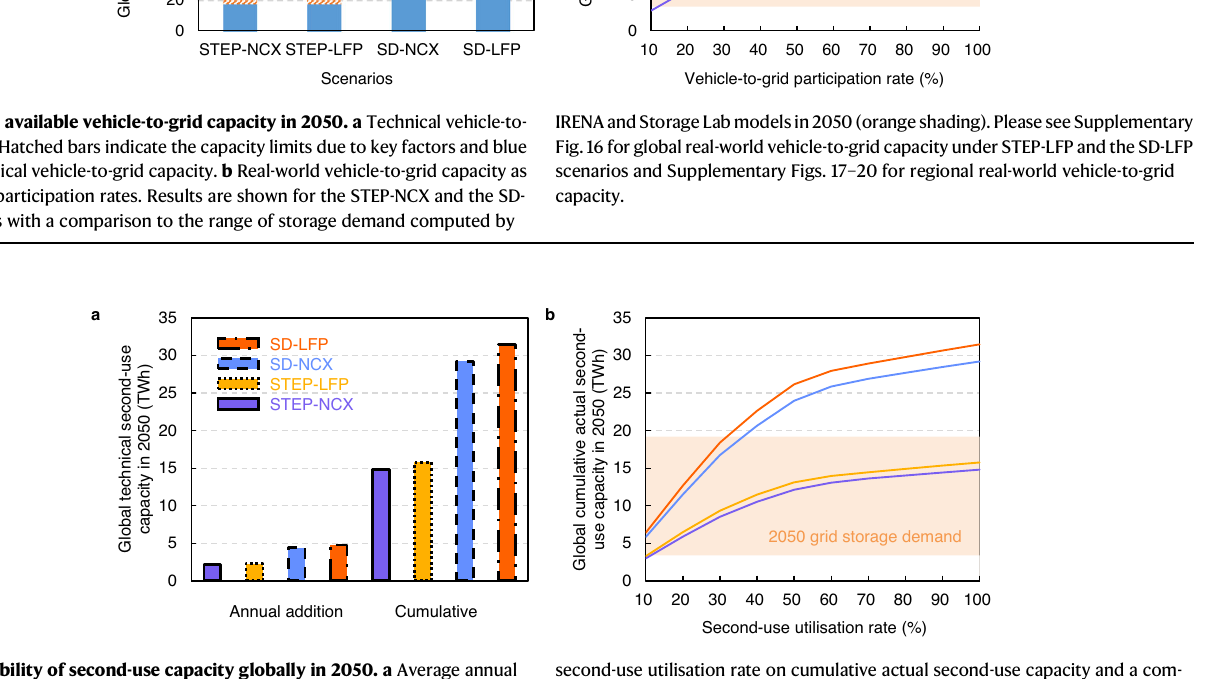
(SoH) drops below 70%-80% 7 (de fi ned as actualcapacity aspercentage